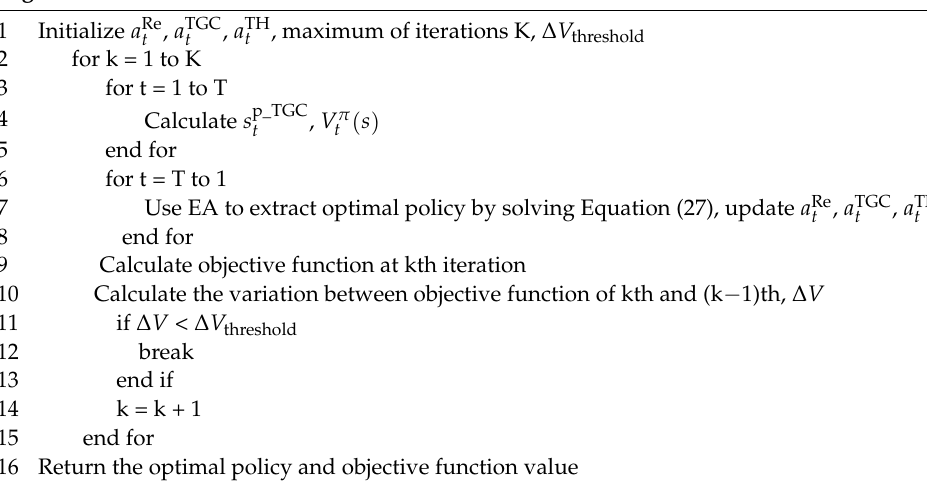
Algorithm 1 : Solution based on DP and